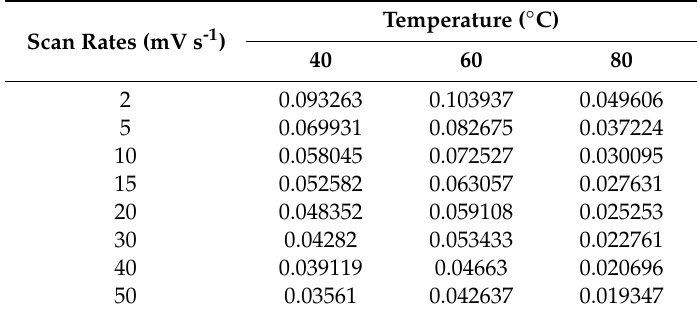
Table 1. Specific capacitance of CuO / Cu foam electrodes.